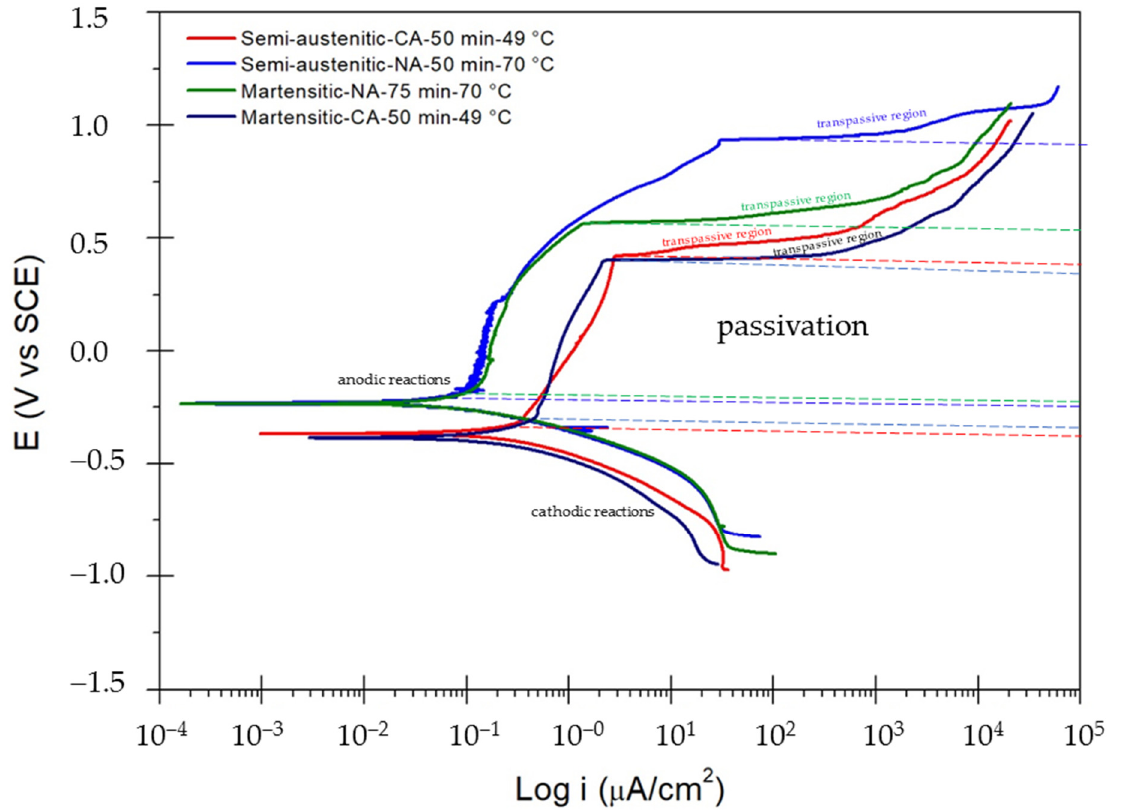
Figure 3. Potentiodynamic polarization curves for passivated martensitic and semi-austenitic. PHSS in 5 wt.% NaCl solution.